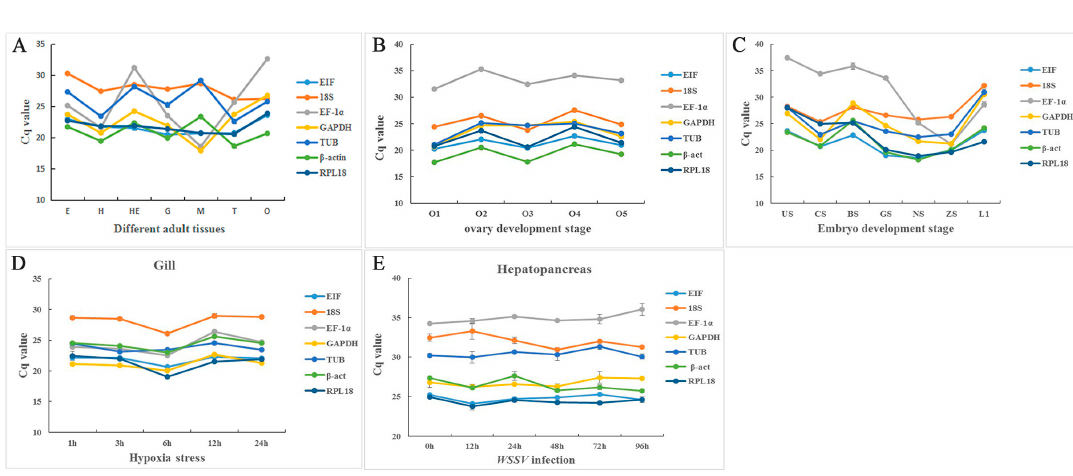
‘Group’ in this table represents how many states or tissues the genes are studied in. Each means five time points during hypoxia stress, six time points during WSSV infection, seven different organizations in adult tissues study, five different ovarian stages, and seven different embryo stage. WSSV —white spot syndrome virus.